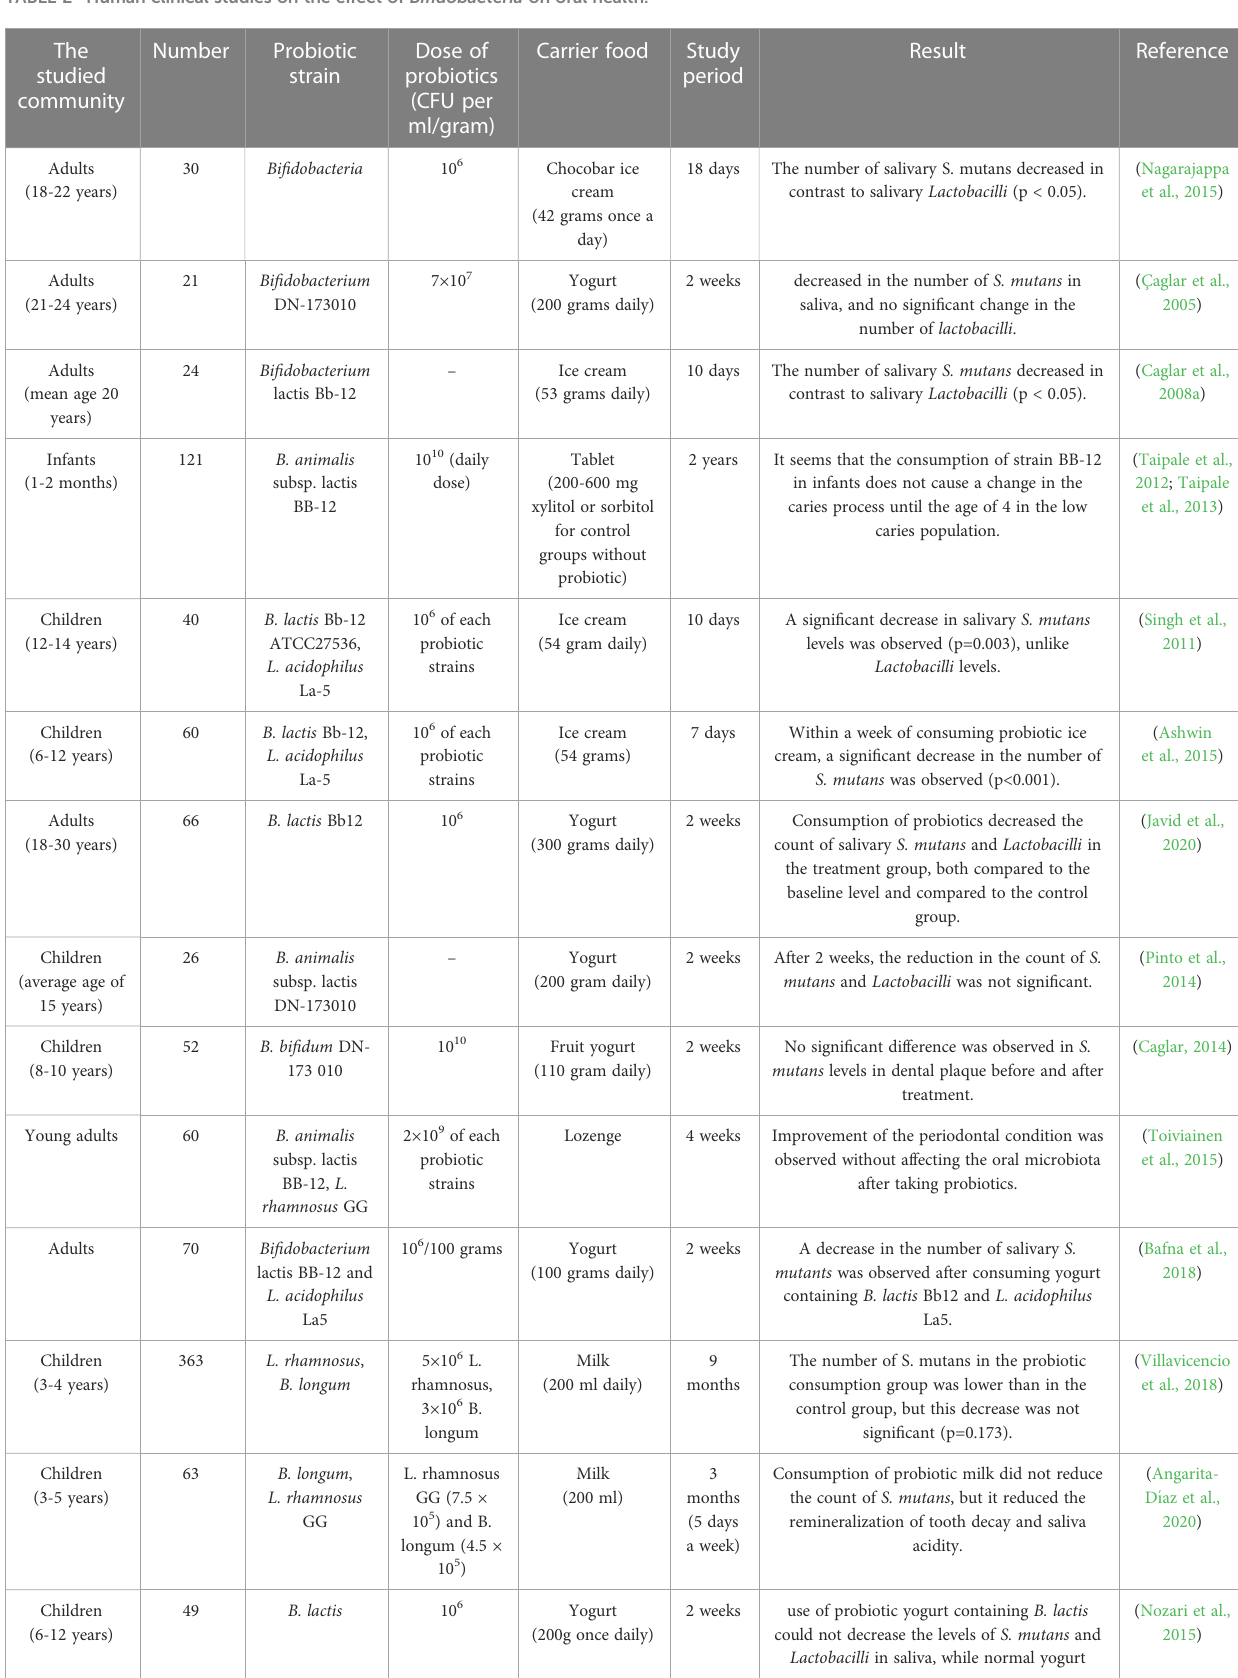
TABLE 2 Human clinical studies on the effect of Bi fi dobacteria on oral